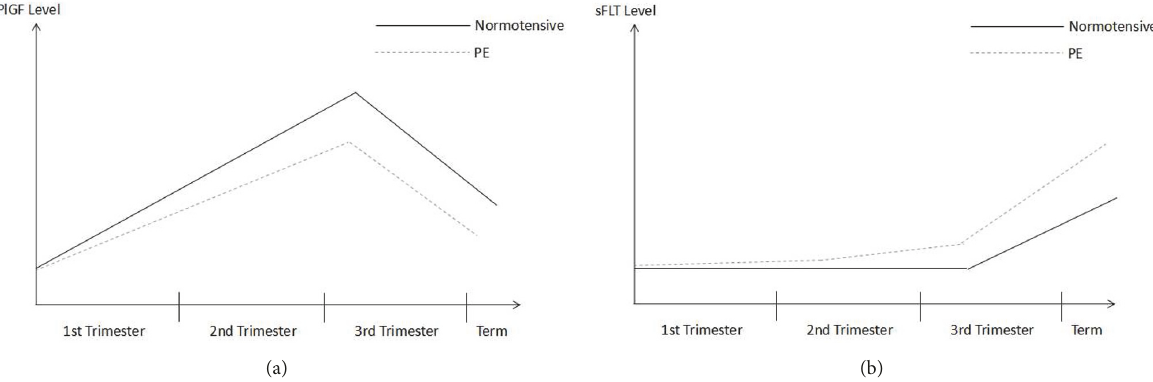
Figure 7: Levels of (a) PlGF and (b) sFlt throughout normotensive pregnancy as compared to levels in preeclamptic pregnant